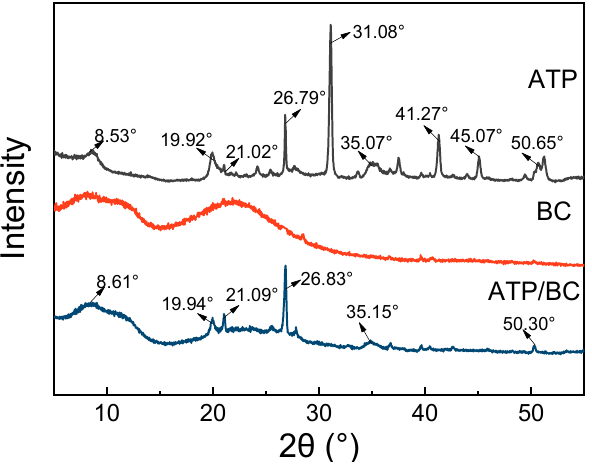
Figure 2. The XRD spectra of the ATP, BC, and ATP/BC. The FTIR spectra of the BC and ATP/BC before and after the adsorption of sulfona- mides are given in Figure 3. The peaks around 3420 cm −1 refer to O–H bond stretching vibration on both the BC and ATP/BC surfaces, and this functional group is derived from cellulose, hemicellulose, and lignin in biomass feedstock [34]. ATP/BC shows a vibration peak at 1614 cm −1 referring to the C=O bond in the carboxyl group [35]. Both BC and ATP/BC showed strong peaks around 1080 cm −1 , which can be assigned to C–O stretching vibrations in esters and ethers [23]. The peaks near 800 cm −1 should be a C–C bond, indicating the possible presence of olefins and aromatic functional groups inside the adsorbents [36]. The peaks at around 460 cm − 1 were deemed to be the Si–O stretching vibration [30]. Compared with the FTIR spectra of ATP/BC, the peaks at 3433 cm − 1 and 1081 cm − 1 moved to the left and there was no peak at 1614 cm − 1 in the BC FTIR spectra, which indicated that the structure of BC was changed by the addition of ATP.